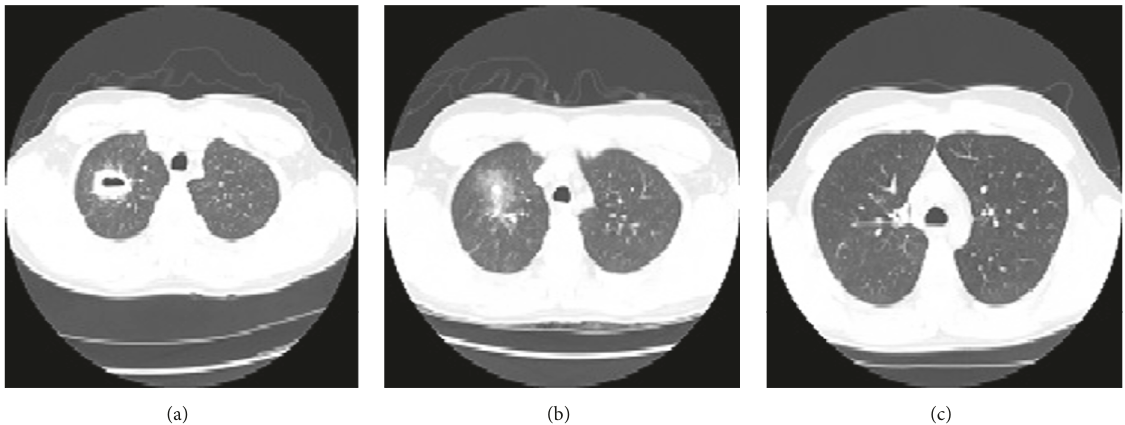
Figure 2: (a) Chest axial view of CT performed on the day of admission, showing a thick-wall cavitary lesion (6.0 × 1.6 × 3.5 cm) in the right upper lobe of the lung. (b) Chest axial view of CT performed at 2-month follow-up, showing foci with ground glass opacity in the anterior right upper lobe of the lung surrounding a 9.9 mm nodular density. (c) Chest axial view of a CT performed at 3-month follow-up, showing complete resolution of the right upper lobe cavitary